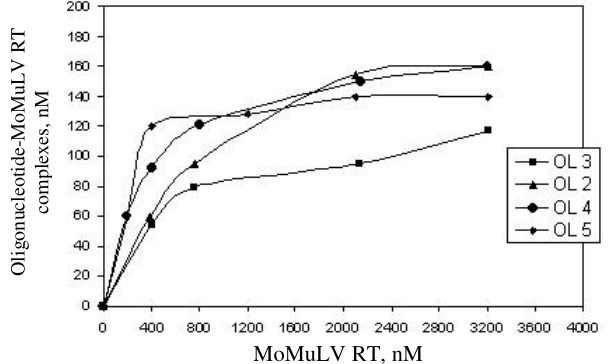
Figure 1. Binding curve of MMLV RT to duplex and dumbbell oligonucleotides.